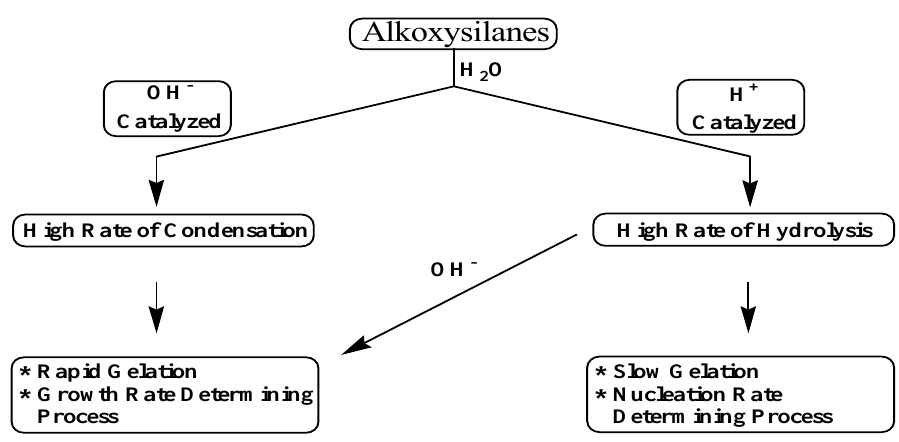
Figure 11. Effect of pH on hydrolysis and condensation